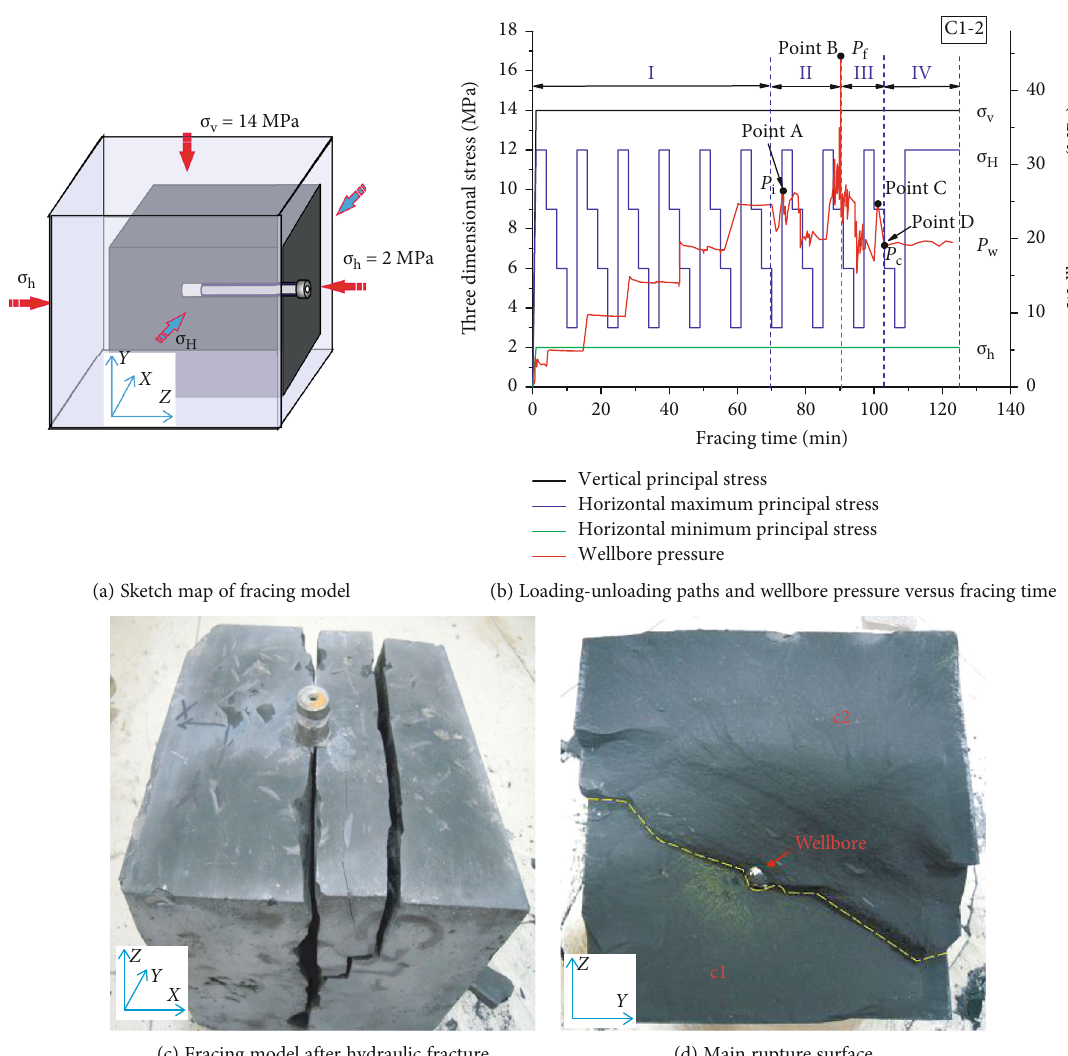
Figure 14: Loading-unloading paths and failure patterns for specimen